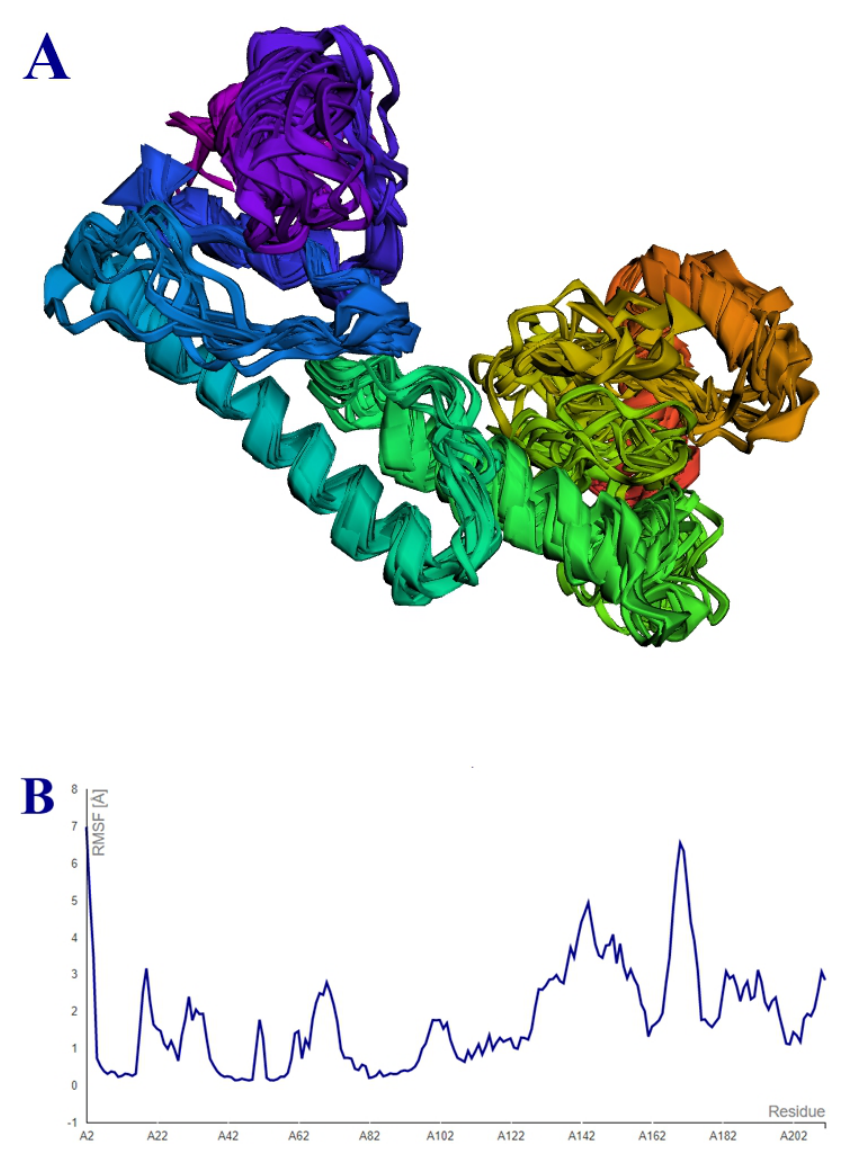
Figure 10. ( A ) Superimposed 3D structure. ( B ) RMSF graph .